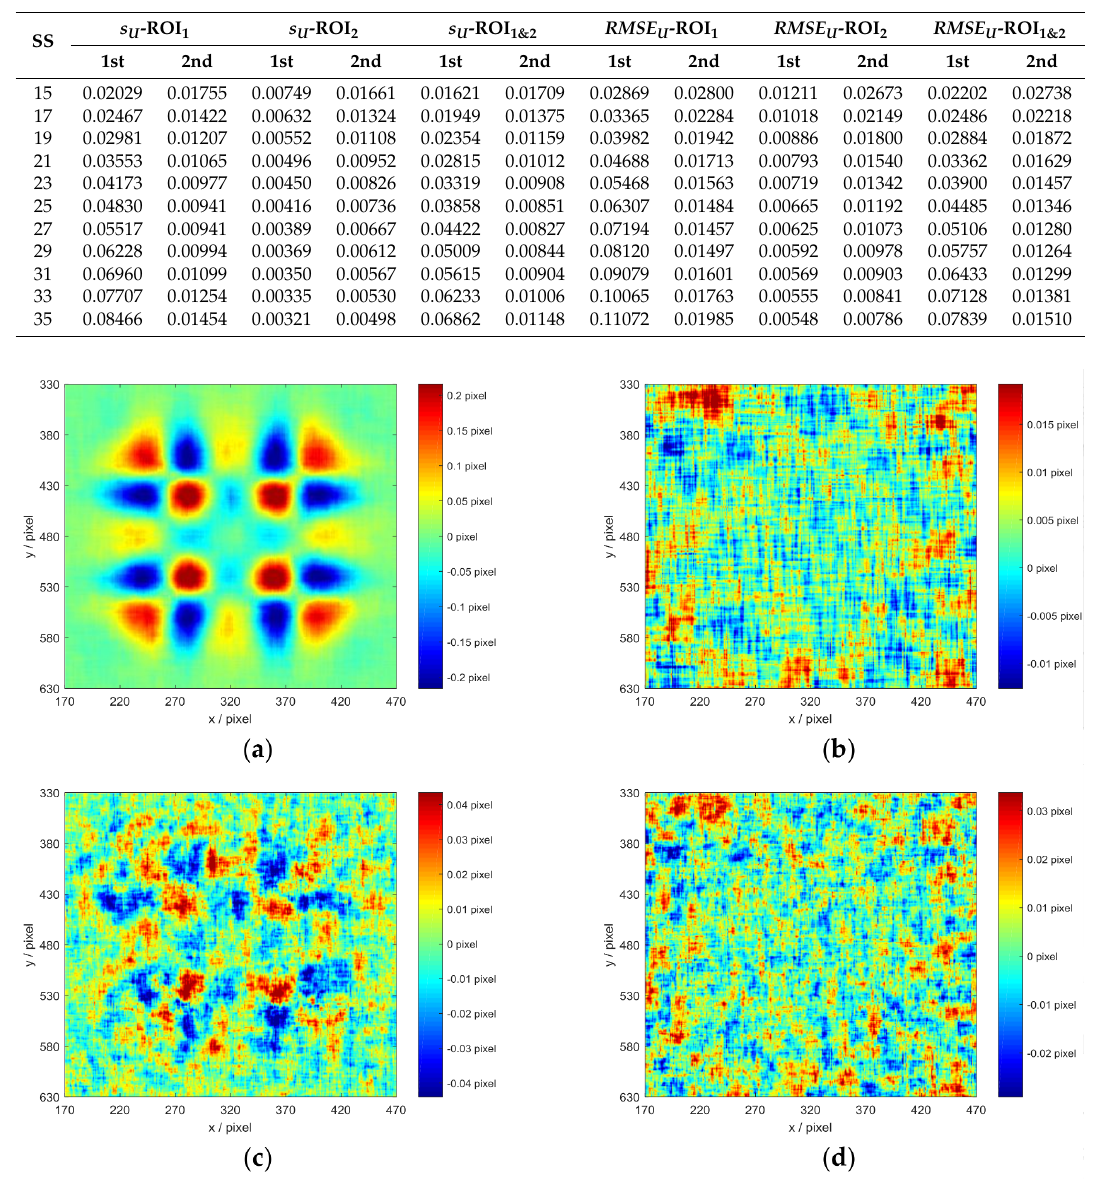
Figure 4. Error distribution maps with a subset size of 27 × 27 pixels: ( a ) Error distribution map of ROI 1 measured by IC-GN 1 ; ( b ) Error distribution map of ROI 2 measured by IC-GN 1 ; ( c ) Error distribution map of ROI 1 measured by IC-GN 2 ; and ( d ) Error distribution map of ROI 2 measured by IC-GN 2